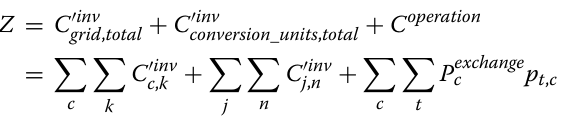
Grid nodes and the edges between them exist on both grid levels and for each